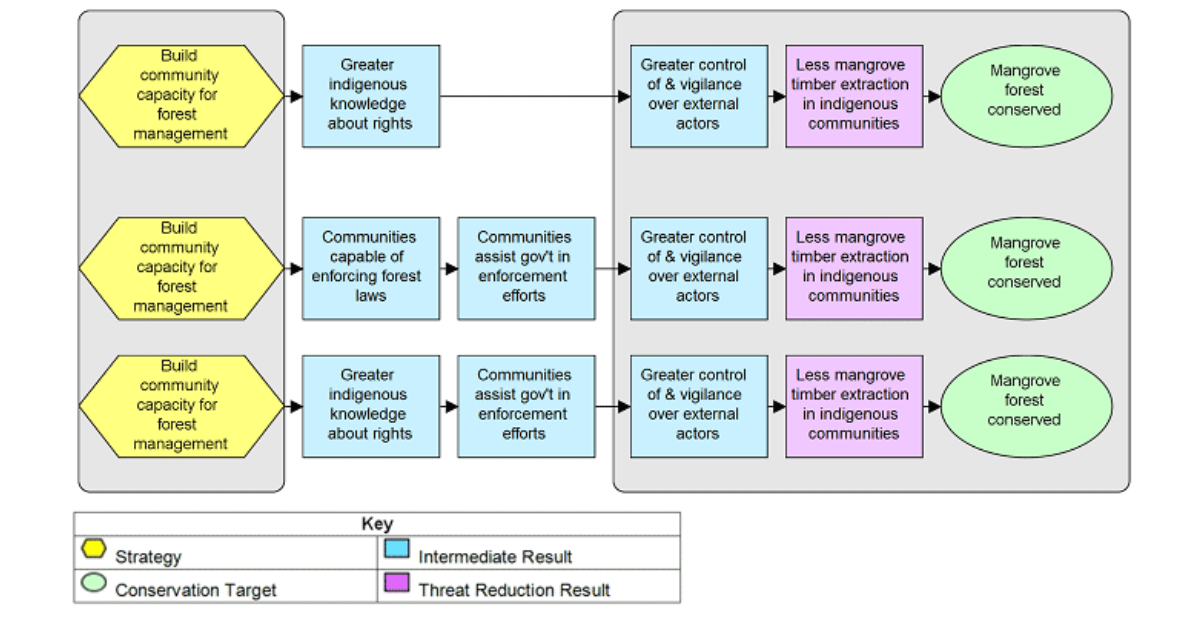
Fig. 8 . How results chains can assist cross-project